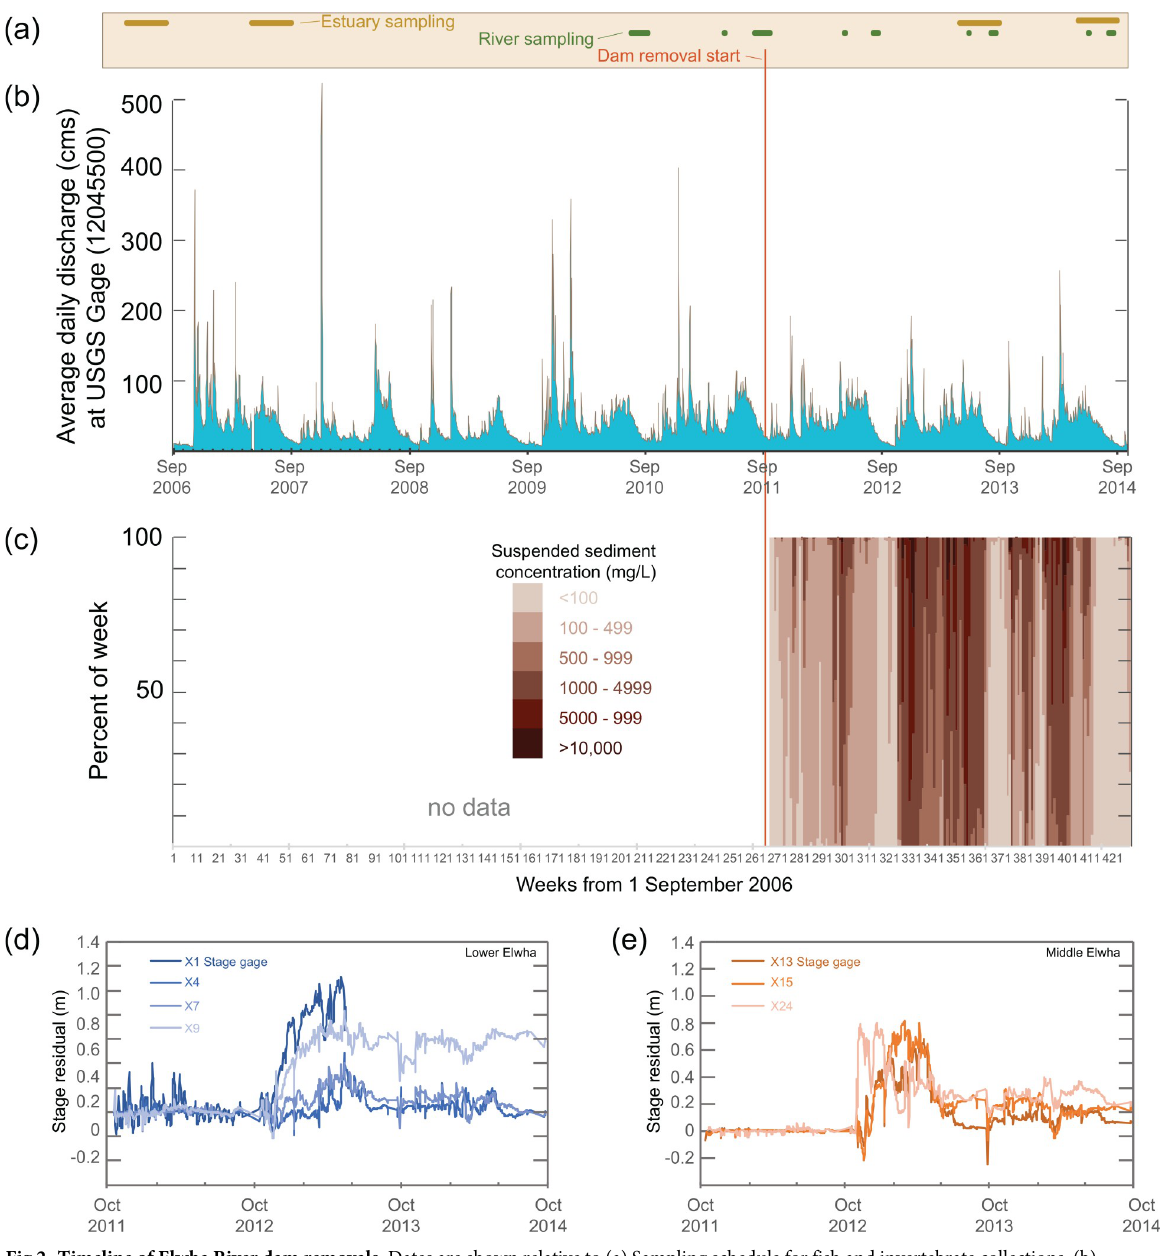
Fig 2. Timeline of Elwha River dam removals. Dates are shown relative to (a) Sampling schedule for fish and invertebrate collections, (b) average daily discharge measured at U.S. Gological Survey (USGS) McDonald Bridge Gage (#12045500, [15]) during water years WY2006 - WY2014, (c) suspended sediment concentration histogram [16] showing the percent of weeks spent in six different concentration bins based on 15-minute turbidity measurements downstream of both dams [5], and a stage-discharge residual analysis based on Anderson and Konrad [17] showing how sediment release from dam removal changed bed elevations across a network of river stage recorders operated by Bountry et al [18] in (d) the Lower and (e) Middle Elwha River. The number of each stage recorder increases in an upstream direction (i.e., X1 closest to the river’s